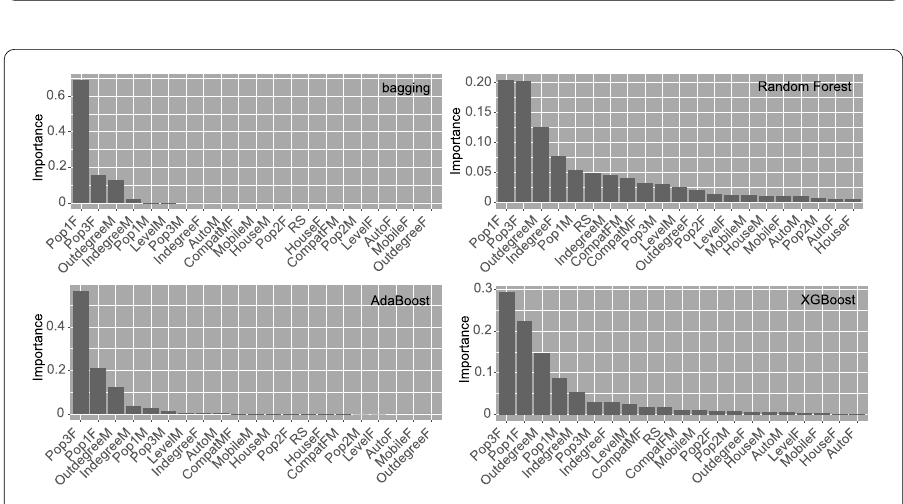
Figure 10 Attribute relative importance rankings when men send messages to women for different classification methods. The horizontal axis indicates the attributes and the vertical axis indicates their corresponding importance. For bagging, Random Forest, and AdaBoost, the relative importance of each variable in the classification task is measured by the Gini index, and for XGBoost the relative importance is measured by the Gain